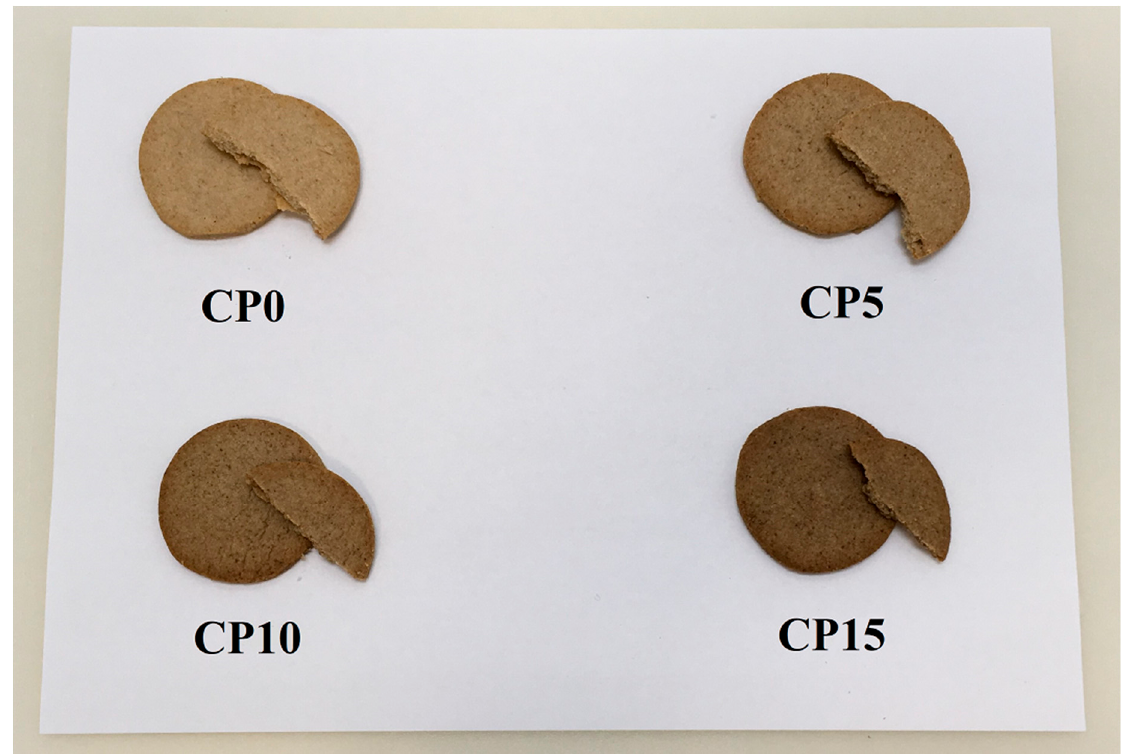
Figure 1. The prepared biscuits. CP0-0 g/100 g house cricket containing flour mixture-based biscuit, CP5-5 g/100 g house cricket containing flour mixture-based biscuit, CP10-10 g/100 g house cricket containing flour mixture-based biscuit, CP15-15 g/100 g house cricket containing flour mixture-based biscuit.